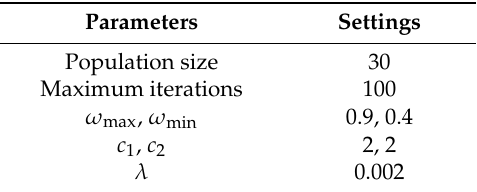
Table 4. Parameter settings in the proposed method.